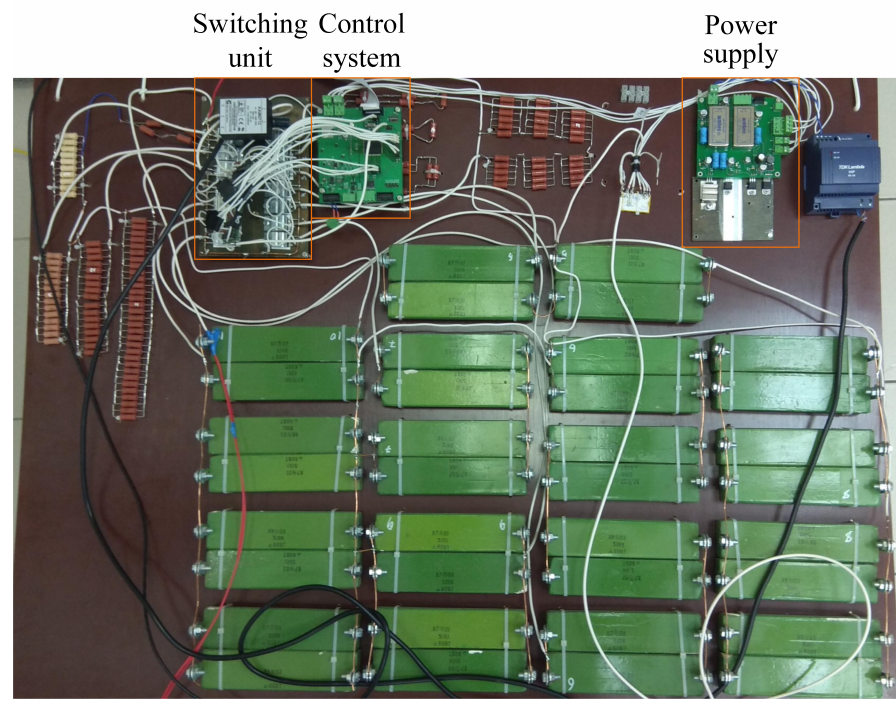
Figure 14. Block of resistances.